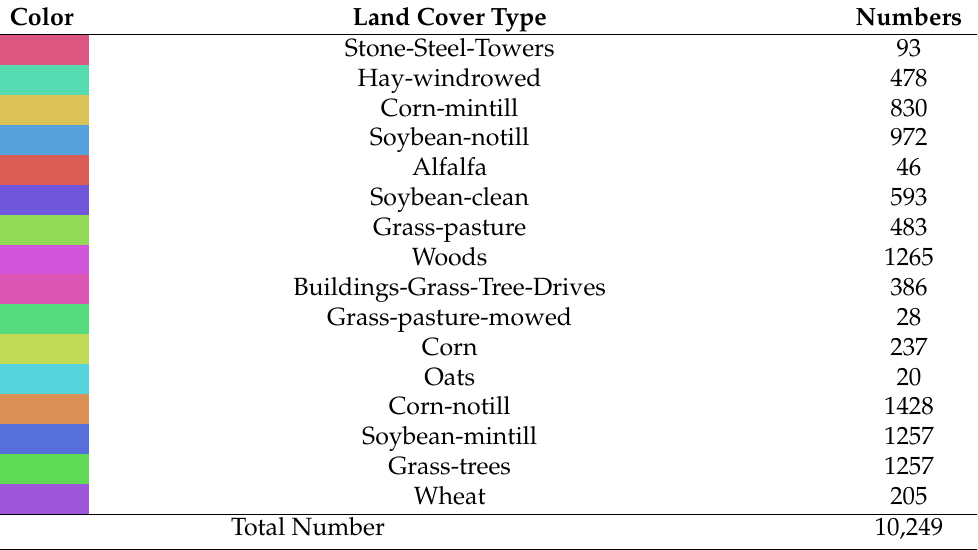
Table 1. background color and number of land cover classes on indian pines.